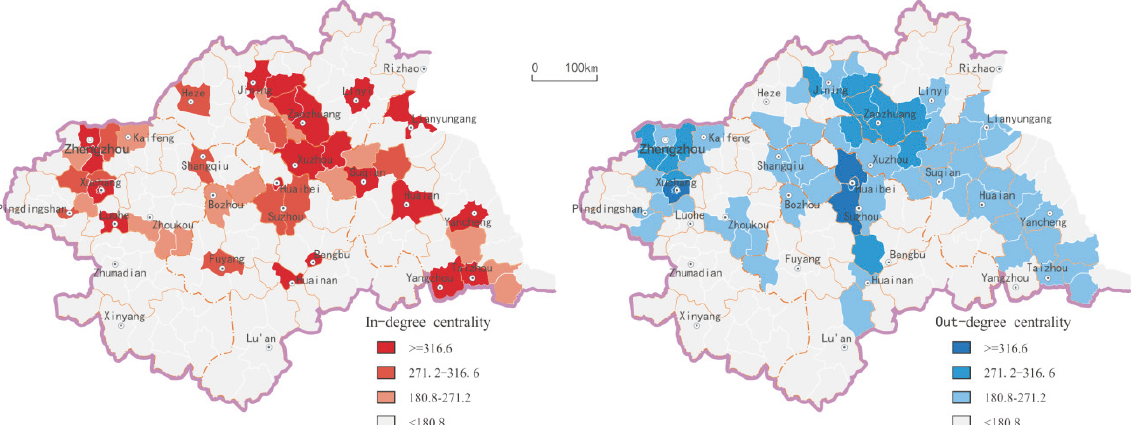
Figure 5: Degree centrality analysis results of the HRB cities in 2014.